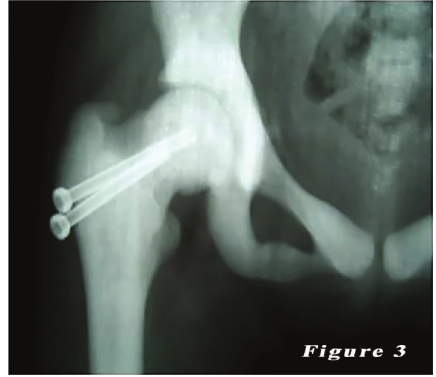
Figure 3: Her last radiography. It looks like fracture